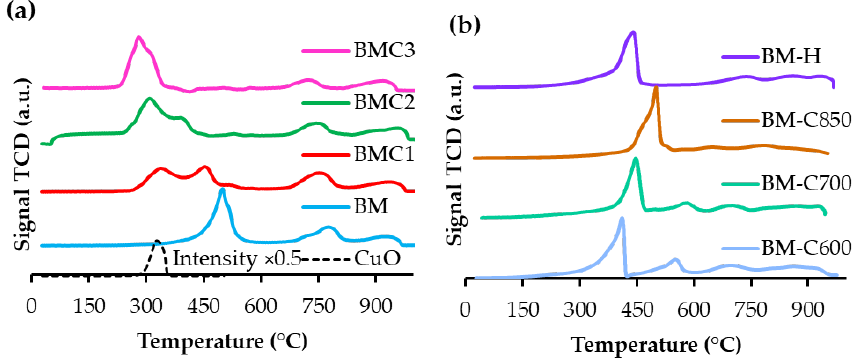
Figure 4. Hydrogen consumption profiles in TPR conditions of ( a ) BaMn 1 − x Cu x O 3 series and ( b ) BaMnO 3